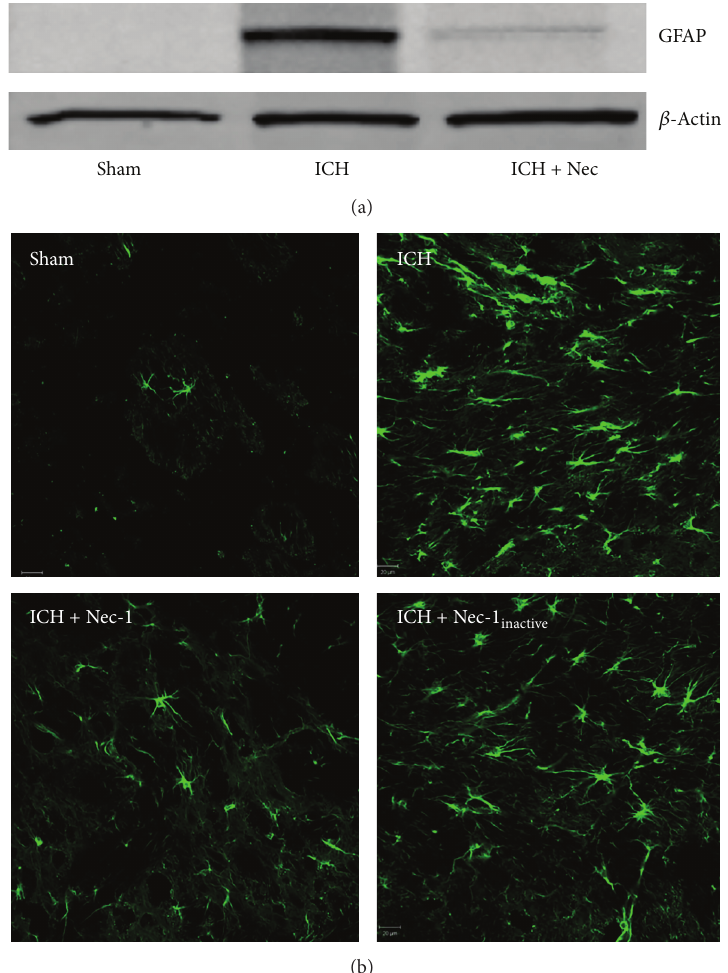
Figure 4: Effect of Nec-1 on ICH-induced reactive gliosis. Reactive astrogliosis was visualized by (a) Western blotting or (b) immunohisto- chemistry for glial fibrillary acidic protein (GFAP) at 72 h after ICH. GFAP immunoreactivity was increased and exhibited a characteristic stellate morphology after ICH. Administration of Nec-1 significantly reduced these effects whereas Nec- 1 representative of 5 mice per group. Scale bar = 20 𝜇